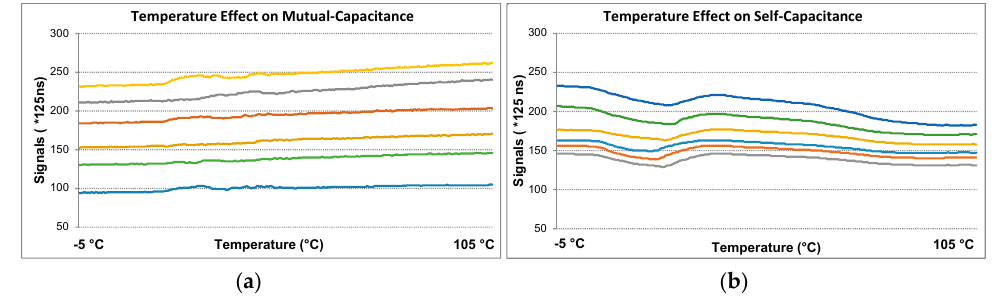
Figure 10. The effect of temperature change ( a ) for mutual-capacitance; ( b ) for self-capacitance.